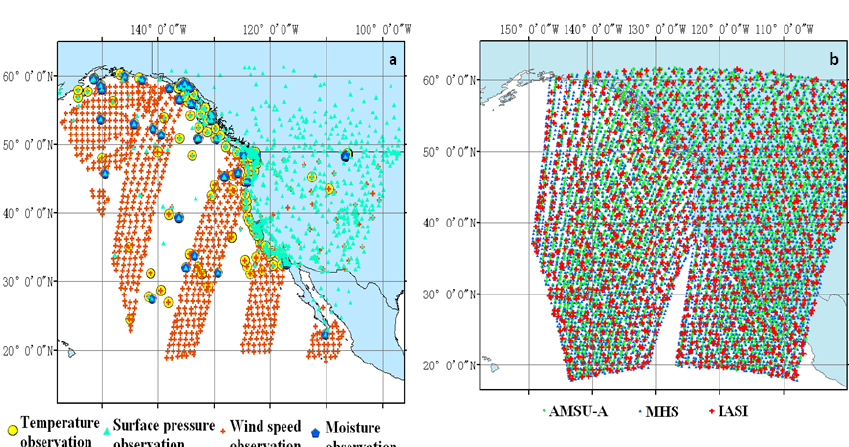
Figure 1. Distribution of observations. (a) Conventional data on 1 July 2012 with the atmospheric temperature (yellow), moisture (dark blue), surface pressure (light blue), and wind speed (orange). (b) Scan coverage of AMSU-A (light blue), MHS (dark blue) and IASI (red) radiance at 18:00UTC on 1 July